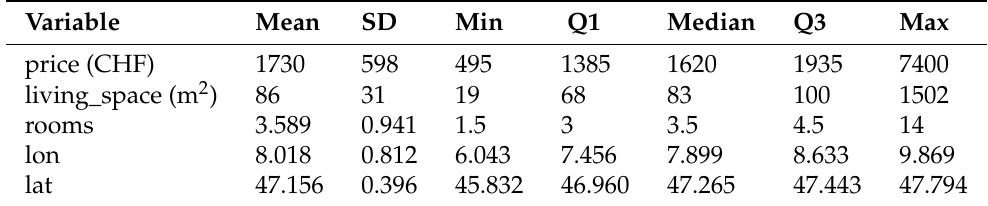
Table 2. Summary statistics for 11,105 SRED flat rentals after pre-processing the features.